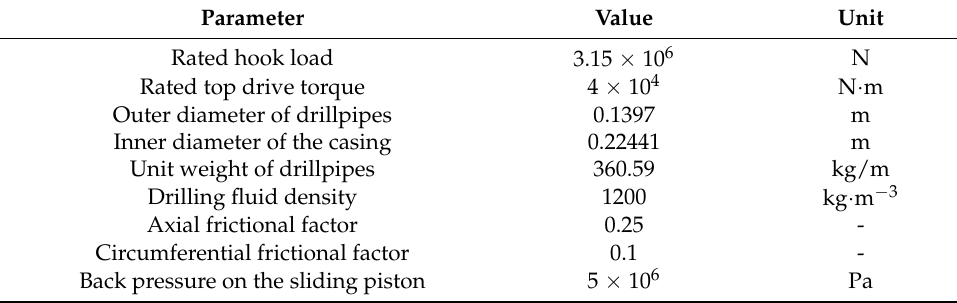
Table 2. Input data of the mechanical extended-reach limit model.